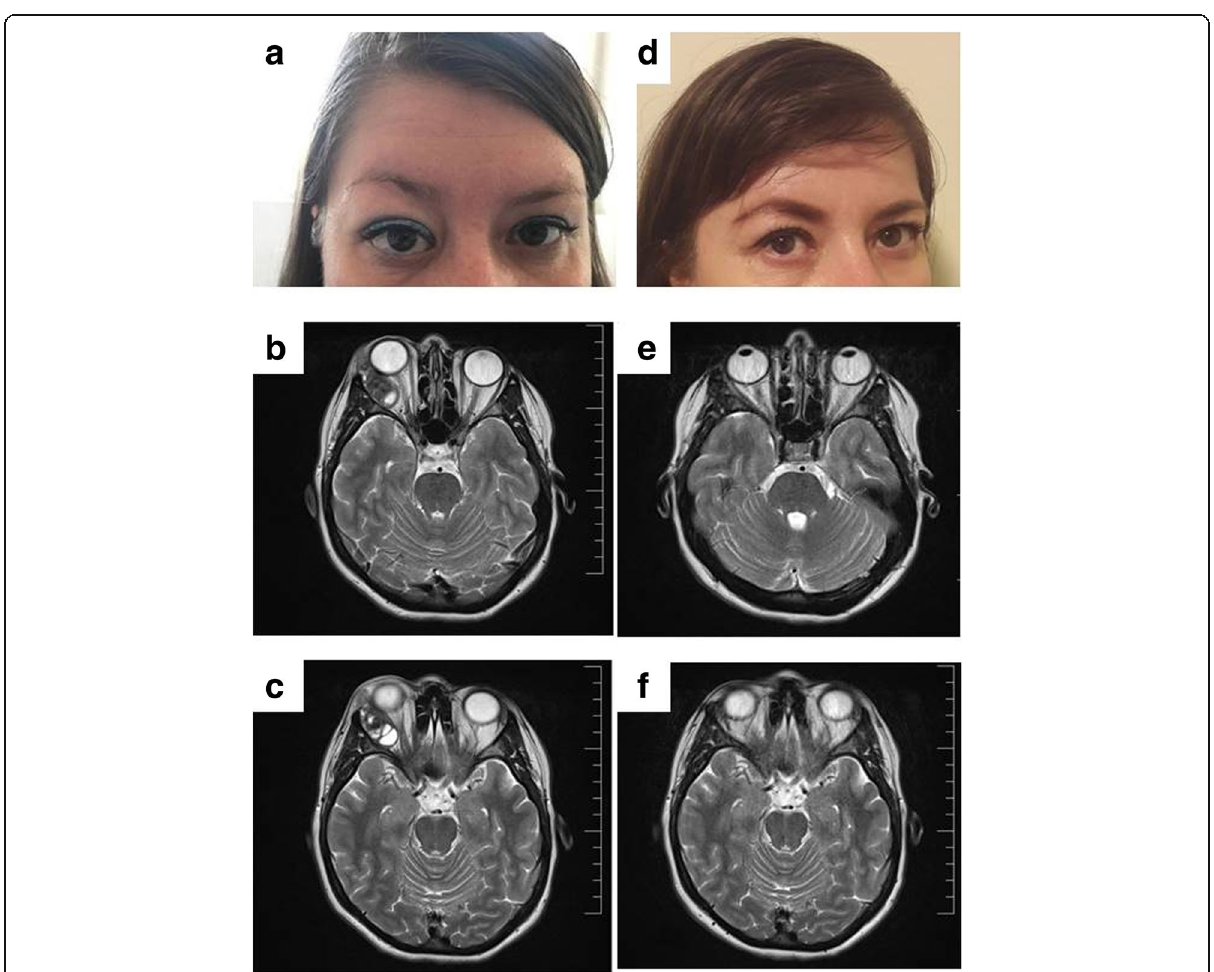
Fig. 1 a Preoperative photograph of the patient showing right exophthalmia. b, c MRI detected a well-defined 4×2,2×2,7cm mass in the right lacrimal gland region that showed a septate pseudocystic appearance and exerted a mass effect on adjacent structures without local bony destruction. d Postoperative case photograph showing normalization of the globe and resolution of right exophthalmia. e, f No evidence of residual tumour was found in the orbital MRI